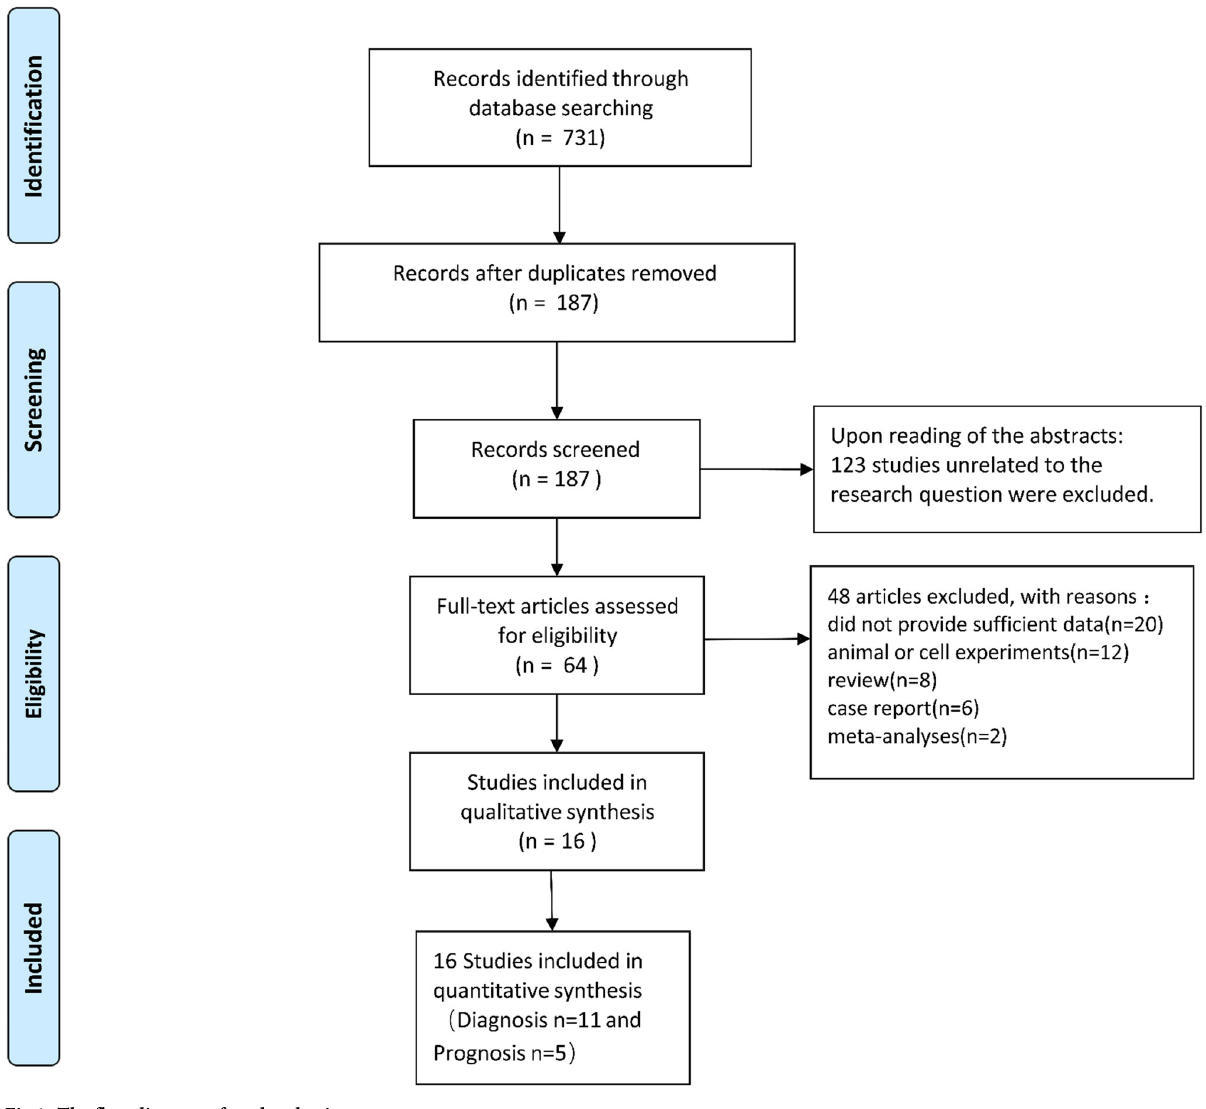
Fig 1. The flow diagram of study